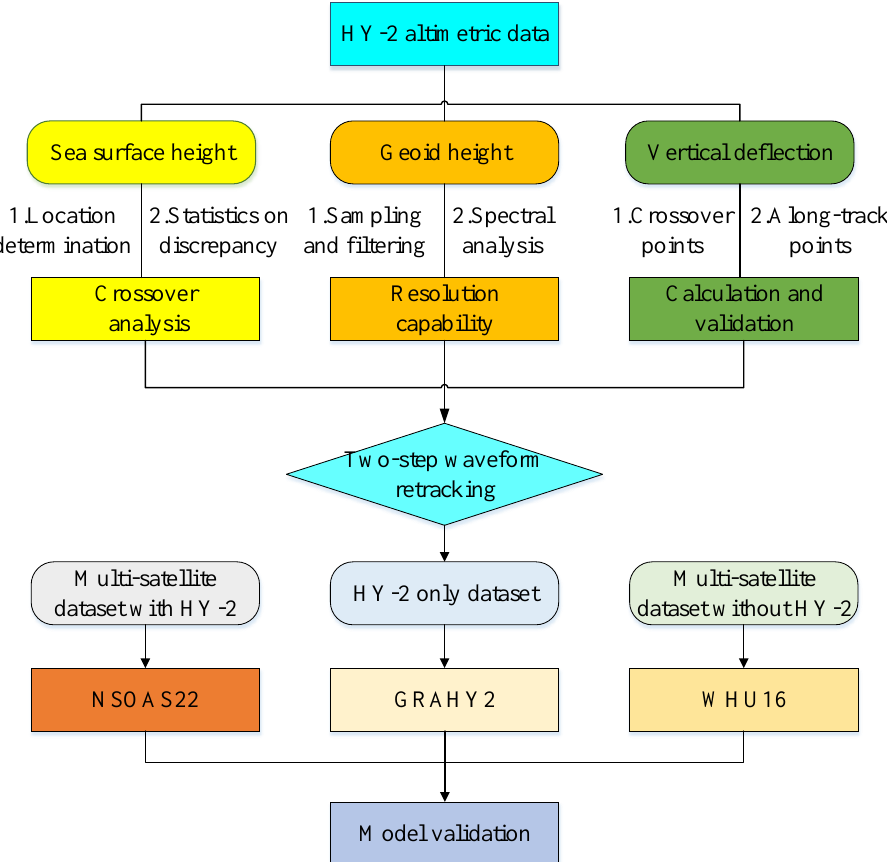
Figure 1. Flowchart for evaluating HY- 2 altimetric data’s performance in marine gravity r esearch.